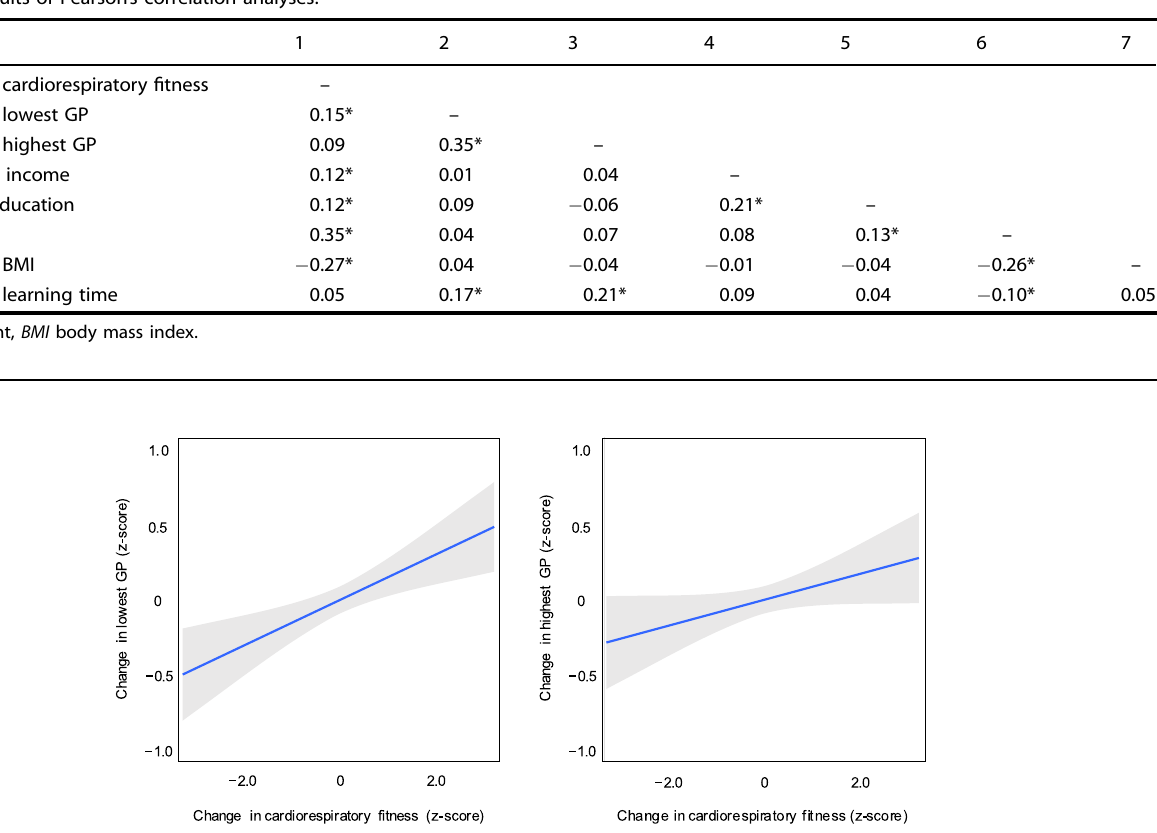
Fig. 1 The associations between changes in cardiorespiratory fi tness and changes in the lowest (left panel) and highest (right panel) GPs. Regression lines are shown with 95% con fi dence bands (shaded